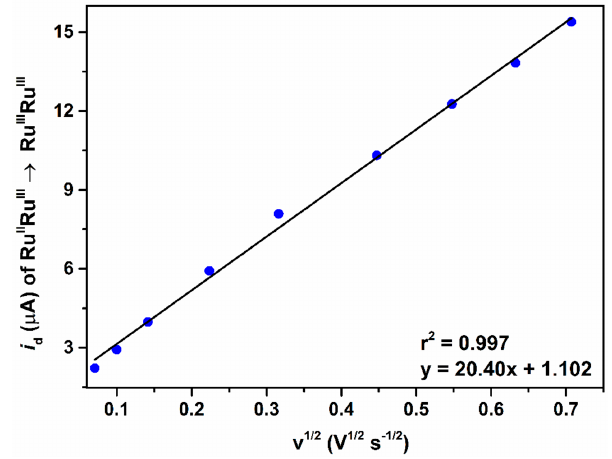
Figure 2. A plot of the anodic peak current ( i d ) of the Ru III Ru III /Ru III Ru II peak vs. the square root of the scan rate. The voltammograms are recorded in 1.0 mM Na 3 [Ru 2 ( µ -CO 3 ) 4 ] and 0.20 M NaClO 4 (pH 7.0) under N 2 atmosphere.